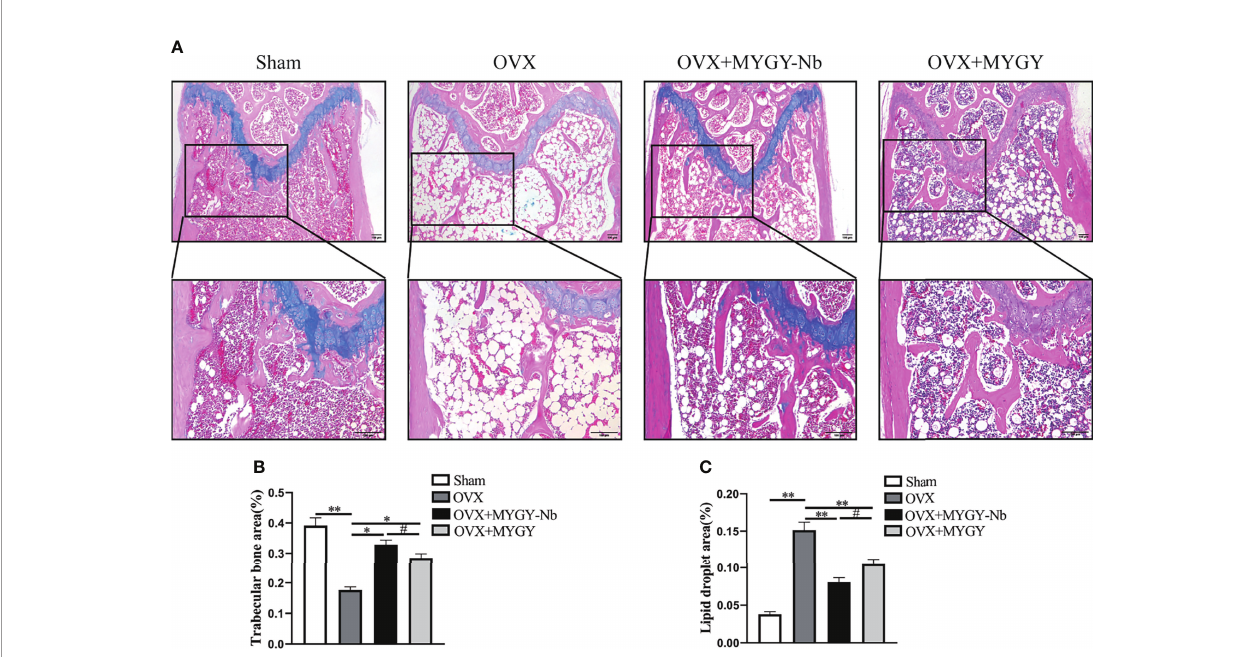
FIGURE 2 | MYGY-Nb and MYGY original formula protect against bone loss in OVX mice. (A) Alcian Blue Hematoxylin/Orange G staining of distal femur. Scale bars: 100 m m. (B) The area of trabecular bone (%). (C) The area of lipid droplets (%). Data were presented as means ± S.D. * P < 0.05; ** P < 0.01; # P < 0.05. n = 6 in each